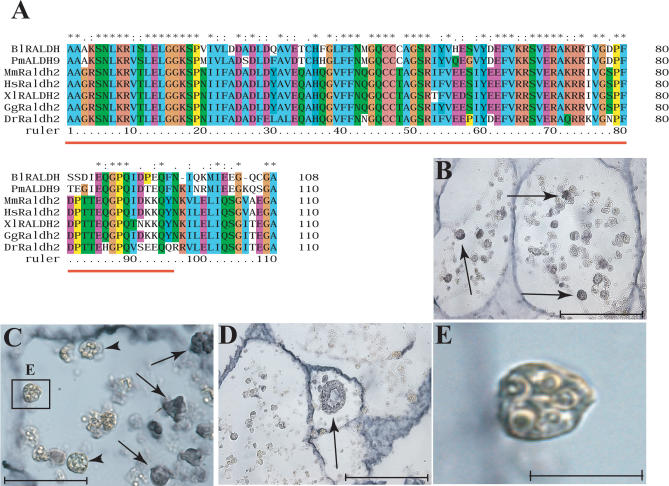
Cloning and Expression Pattern of the Raldh Homologue in Intact Colonies and Regeneration Ampullae(A) A fragment of 110 amino acid exhibiting high homology to the Aldedh domain of the budding ascidian P. misakiensis (Pm) and high sequence similarity to Aldedh2 family members from mouse (Mm), Human (Hs), Xenopus (Xl), chick (Gg), and zebrafish (Dr). A domain search revealed an Aldedh domain conserved in all Aldedh family members (98 amino acid marked by a red line).(B–E) Expression pattern of Bl-Raldh in intact colony and regenerating ampullae. Bl-Raldh is expressed in naïve ampullae, exclusively in a population of circulating macrophage cells (B) (arrows), scattered throughout vasculature. In regenerating ampullae, Bl-Raldh is observed in macrophage cells (C) (arrows) adjacent to aggregates of small cells creating morula-like structures (C) (arrowheads, rectangle), enlargement in (E). In later stages, starting from the blastula-like stage, Bl-Raldh expression appears in developing buds (D) (arrow). Note the staining along the ampullae margins represents nonspecific staining of the tunic matrix. Scale bars in (B) and (D) represent 100 μm. Scale bars in (C) and (E) represent 40 μm and 10 μm, respectively.